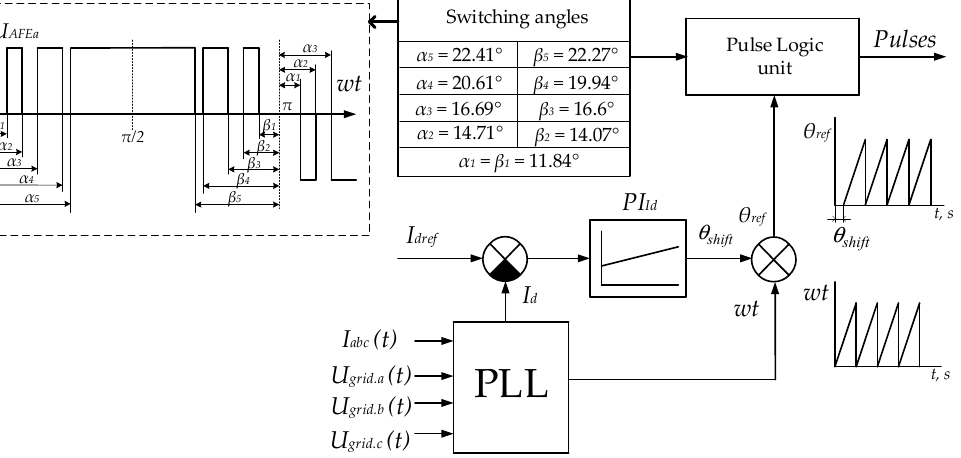
Figure 6. The structural diagram of PWM Fixed Pulse Pattern Control. The AFE input voltage is formed as rectangular impulses with an odd harmonic range, whose amplitudes depend on the quality of impulses over a quarter-period and the switching angle values. The switching angles are selected so that the voltage curve does not have the most significant harmonics. The main harmonic remains at the level set by the modulation index. The correlations between the switching angles are determined by the system of Equation (1) [63].